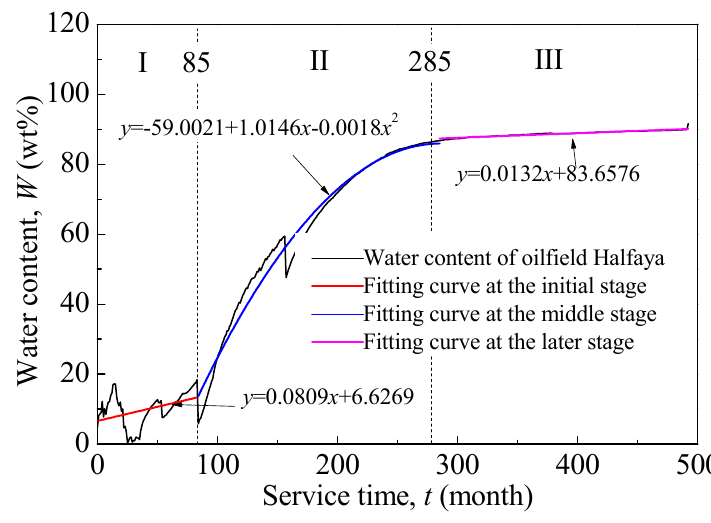
Figure 2. Dependence of water content of oilfield Halfaya on service time. Table 1. Chemical composition of mineralized water in the medium (g · L − 1